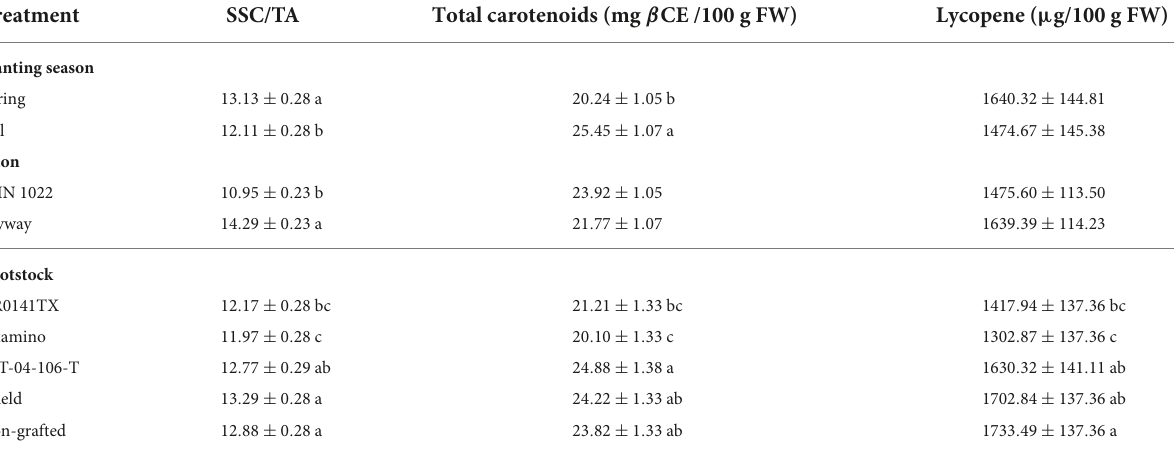
TABLE 8 Soluble solids content (SSC) to titratable acidity (TA) ratio and total carotenoid and lycopene contents of fruit from grafted beefsteak tomato ‘Skyway’ and grape tomato ‘BHN 1022’ in Spring and Fall plantings.